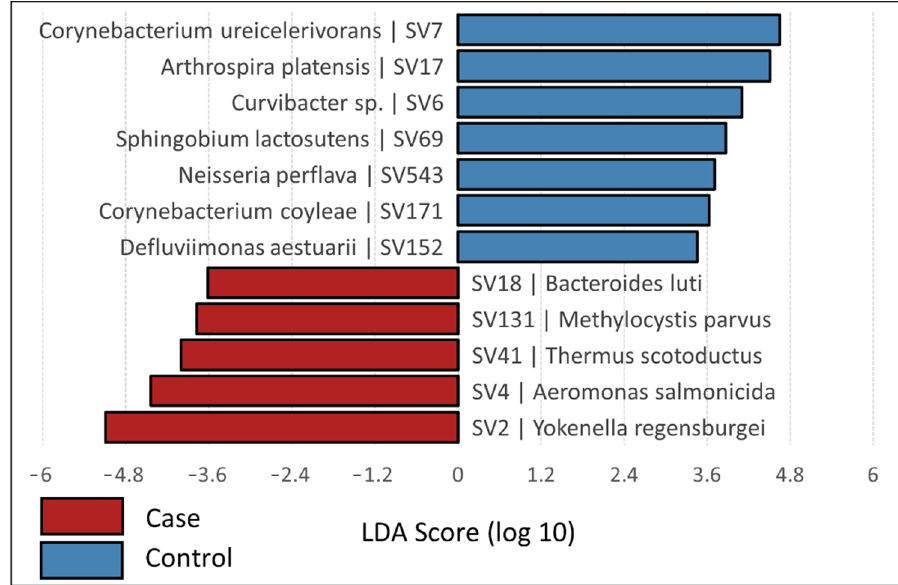
Figure 4. LEfSe analysis displaying differentially abundant SVs between cases and controls, based on a linear discriminant analysis with p < 0.05 for Kruskal–Wallis tests. Each SV is identified with the nearest BLAST result.